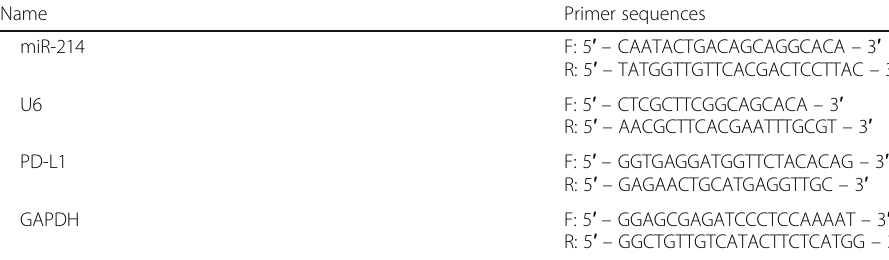
Table 1 Name and sequences of the primers